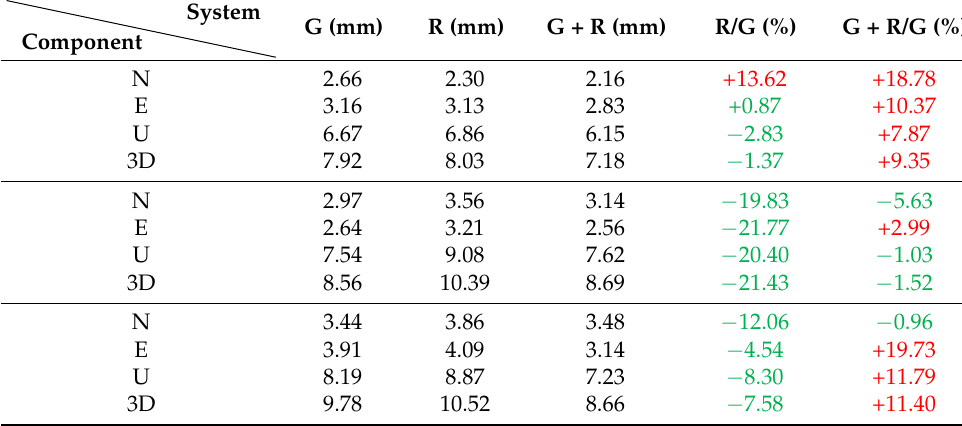
Table 9. The mean RMSE of coordinates for each network estimated with PPP and their compari- son between different processing modes (The positive red and negative green values indicate the percentage increment and reduction of accuracy,